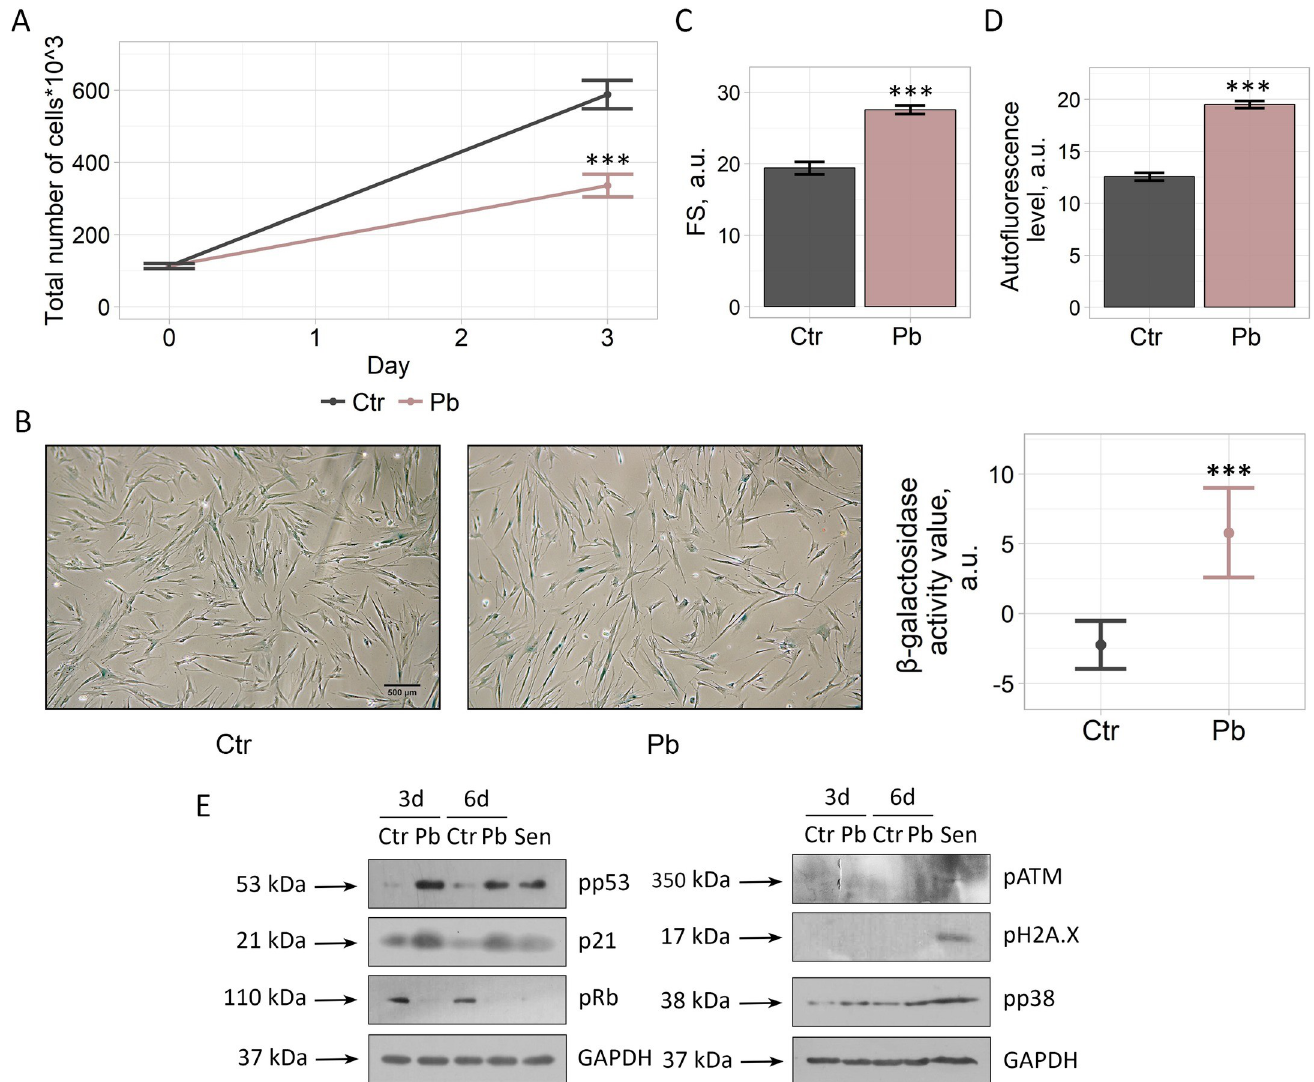
Fig 4. Pb treatment leads to the induction of premature senescence of human embryonic fibroblasts. “Ctr”–control cells. “Pb”–Pb-treated cells. “Sen”–senescent cells. (A) Growth curves, (B) SA- β -Gal staining and quantification, (C) cell size, (D) autofluorescence and (E) western blotting for pp53, p21, pRb, pATM, pH2A.X, and pp38 of Ctr and Pb cells were performed. GAPDH was used as loading control. Scale bar is 500 μ m and valid for all images. Representative results of three independent experiments are